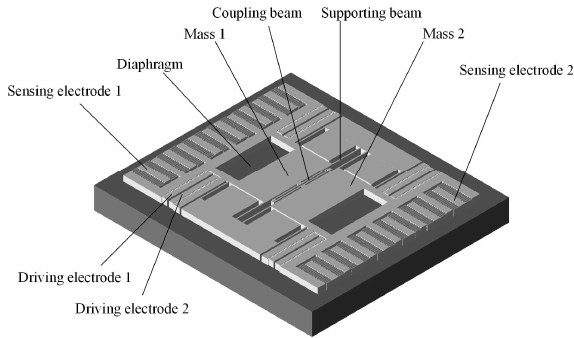
Figure 1. The schematic diagram of the designed silicon resonant pressure sensor.